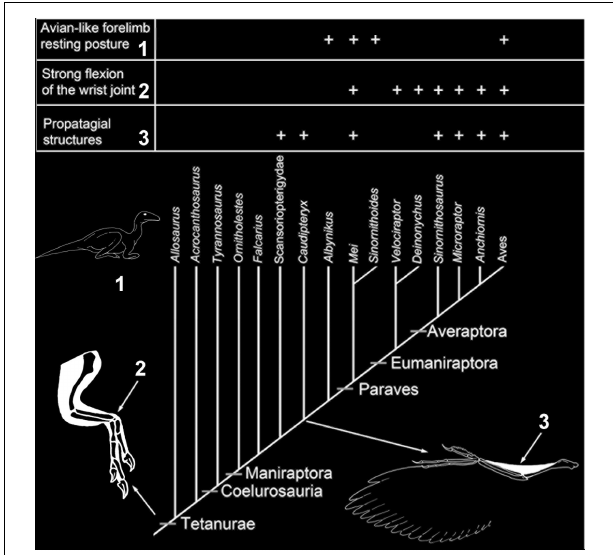
FIGURE 10 | Simplified phylogenetic scheme for Tetanurae, showing the distribution of flexion of the wrist joint and propatagial structures among theropods (modified from Chimento et al.,